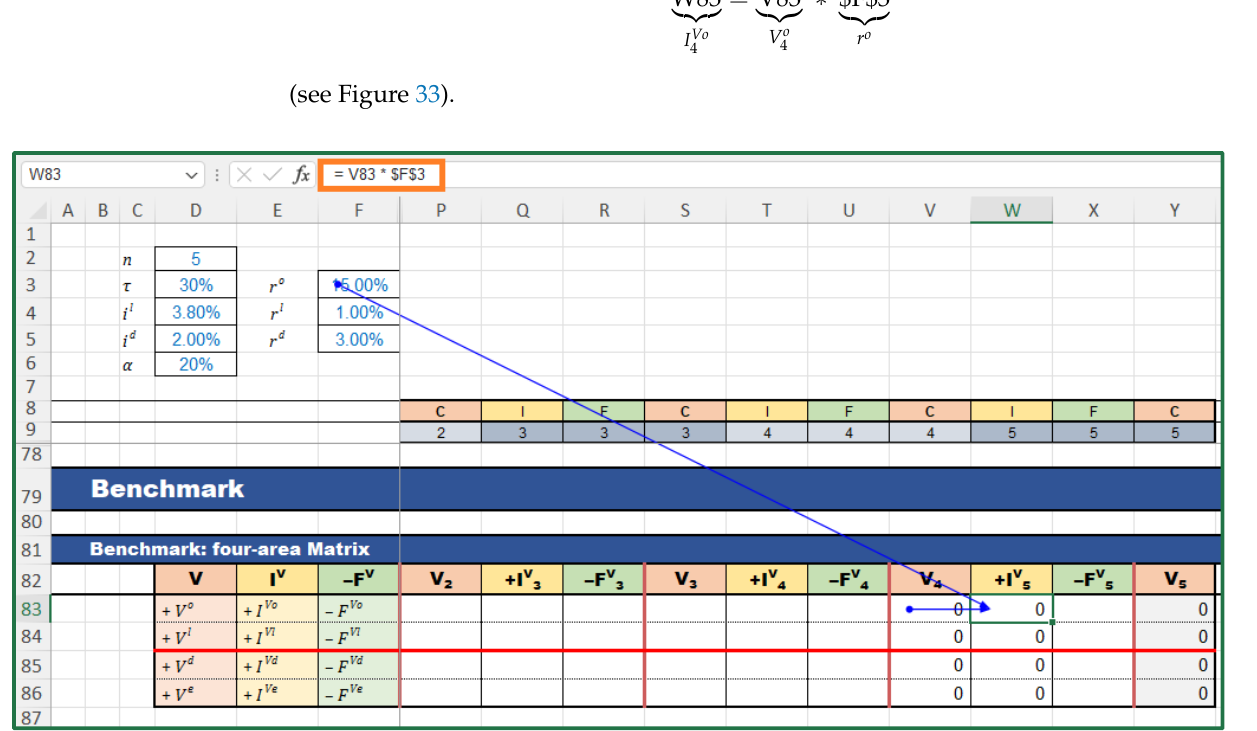
Figure 33. Cell W83 contains the formula for calculating the benchmark profit (“SplitScreenStrip” sheet).